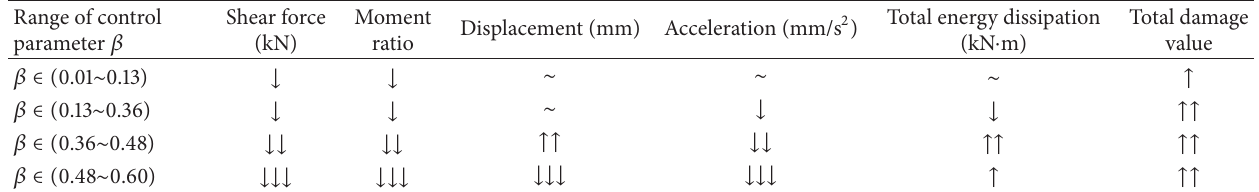
Table 4: Analytical table of the influence of varying closure slip degradation parameter 𝛾 on structural responses and damage. Range of control Shear parameter 𝛾 force (kN) 𝛾 ∈ ( 1.0 ∼ 0.62 ) 𝛾 ∈ ( 0.62 ∼ 0.34 ) 𝛾 ∈ ( 0.34 ∼ 0.15 )